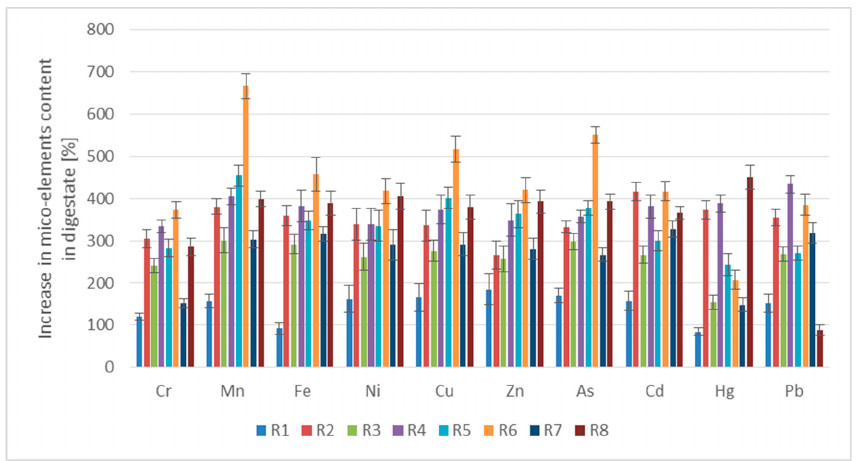
Figure 3. Increase in micro-elements content in digestate within the AD process (average values and